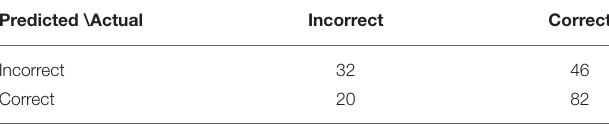
TABLE 2 | Confusion